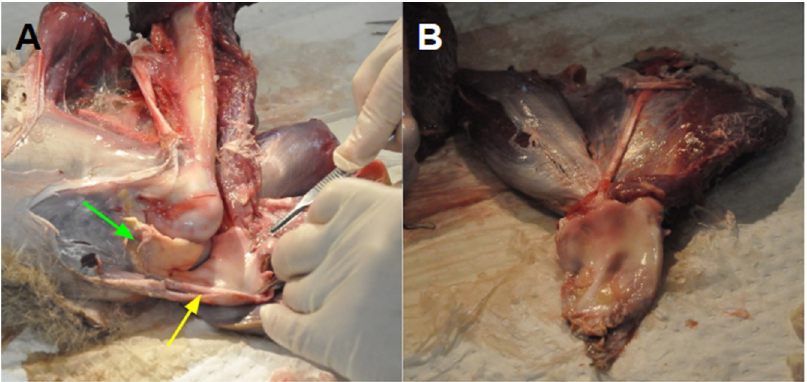
Figure 4. ( A ) Extensor mechanism (yellow arrow) pulled away from the femoral head, revealing a fat pad underneath (green arrow). ( B ) Cu ff -like thickening with tibial attachments